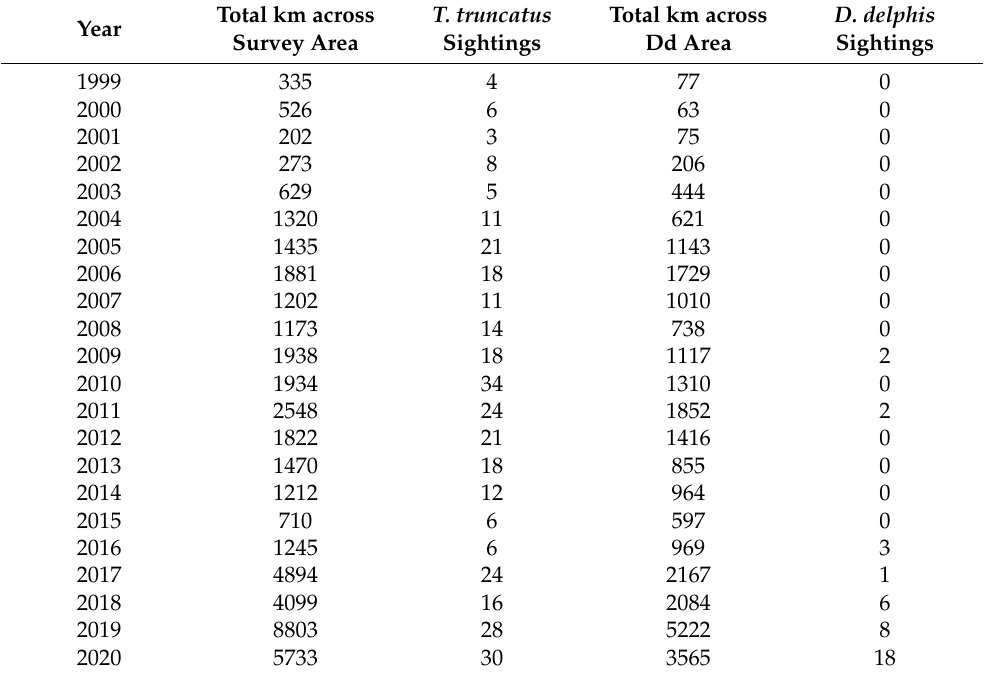
Table 2. Table displaying the number of kilometers surveyed across the entire survey area and across the Dd Area per year, as well as number of T. truncatus and D. delphis sightings per